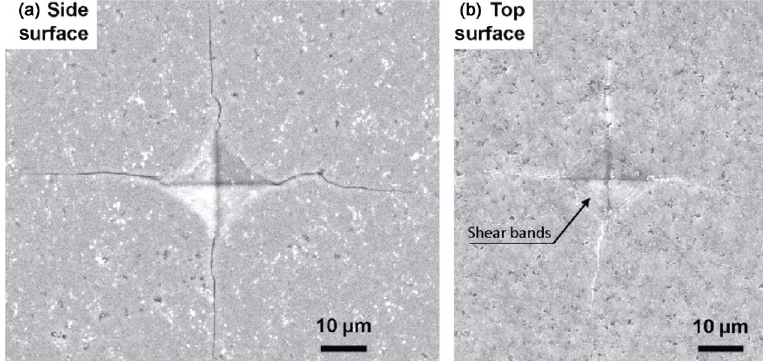
Fig. 40 Vickers indentations on textured B 4 C specimen surfaces: (a) parallel to the c -axis orientation; (b) perpendicular to the c -axis orientation. Reproduced with permission from Ref. [283], © Acta Materialia Inc.